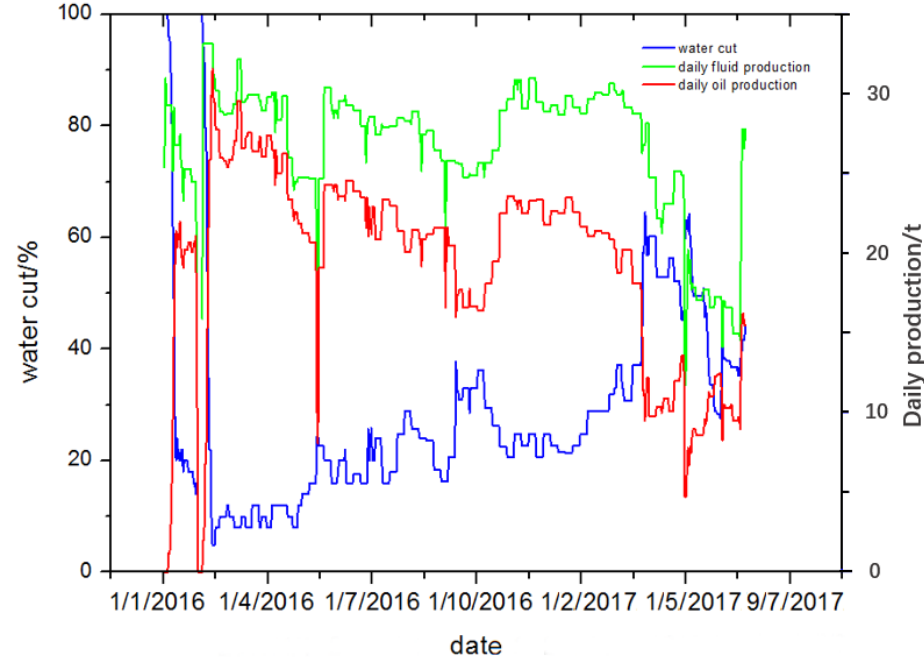
Figure 13. Data of crude oil and liquids production over time in HX well after treatment.